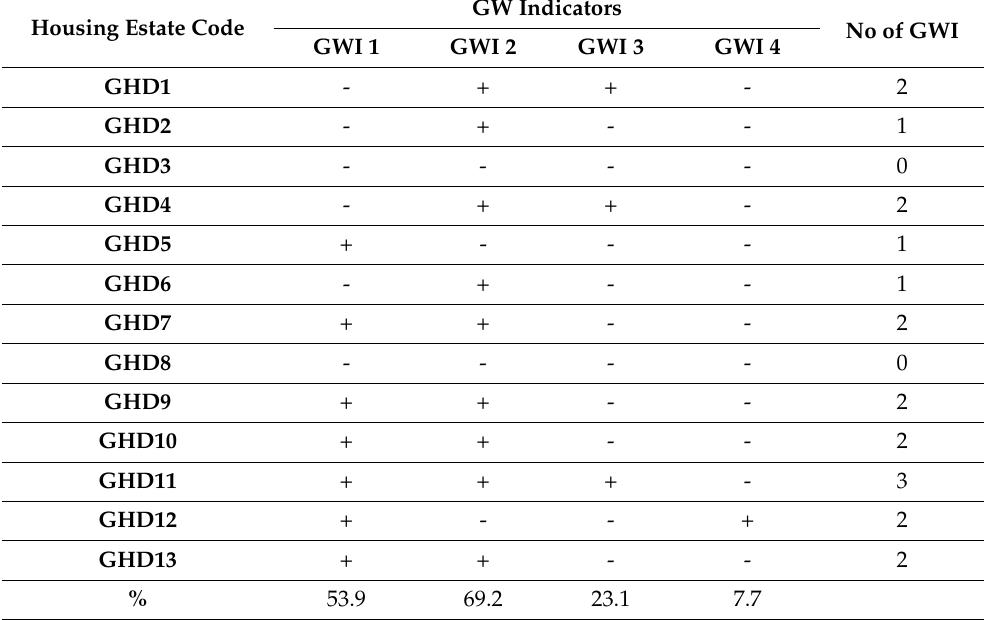
Table 7. GHD: the results of the visual content analysis on GWI.